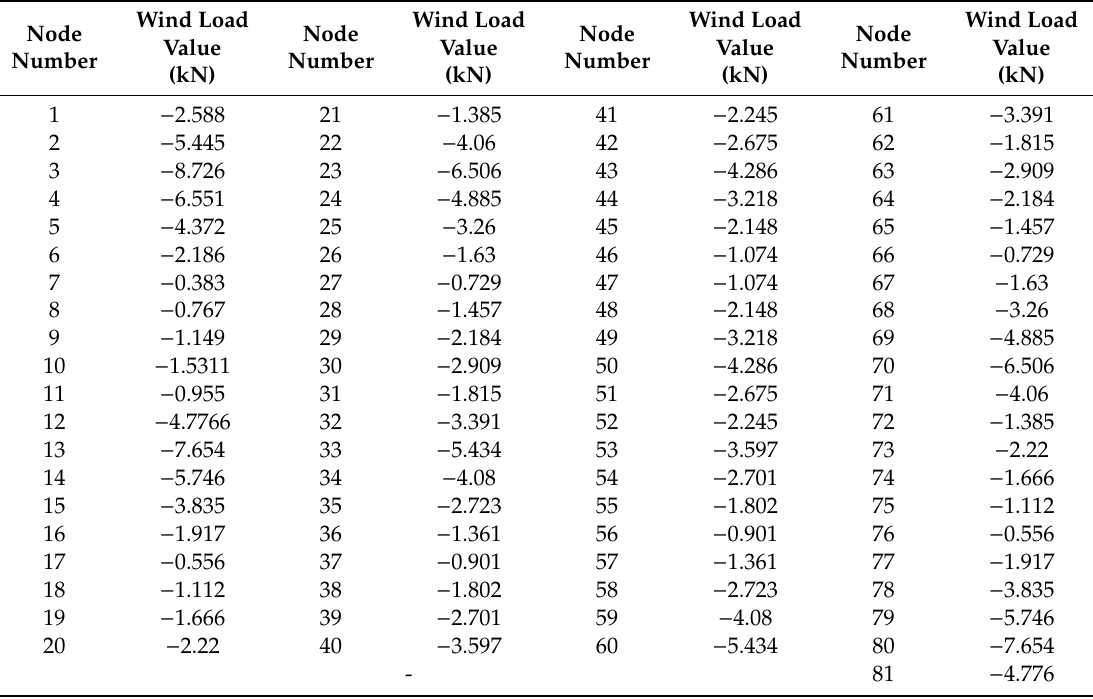
Table 7. Values of the wind load to the individual